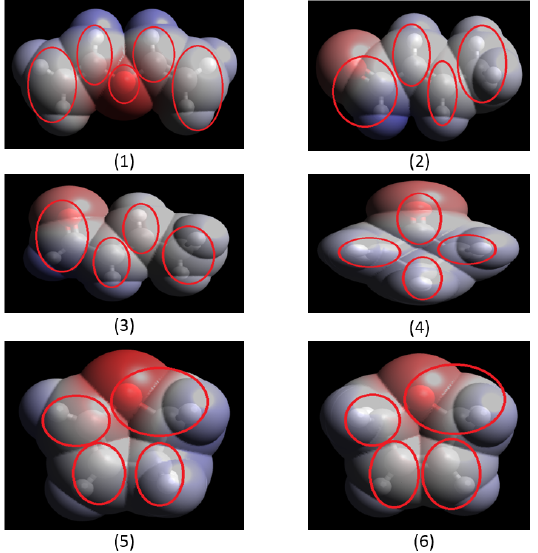
Figure 2. Scattering centres identified using Avogadro software by electrostatic potential surface method: ( 1 ) vinyl ether, ( 2 ) 2-butenal, ( 3 ) cis-2-butenal, ( 4 ) cyclobutanone, ( 5 ) furan, 2, 3-dihydro, and ( 6 ) furan, 2,